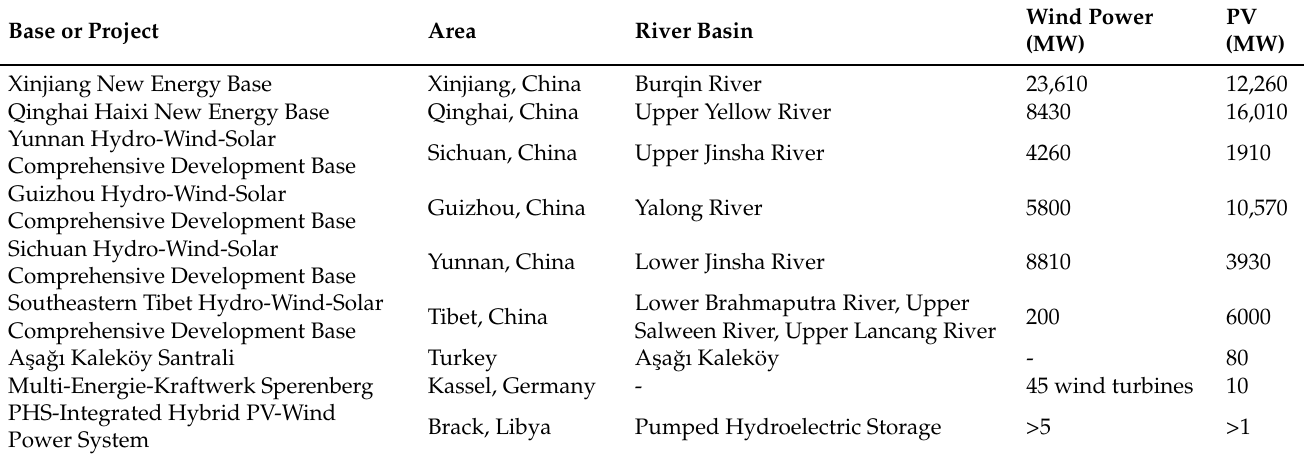
Figure 3. Highest onshore wind ( left chart ) and utility-scale PV ( right chart ) capacity potential countries and the CF tranche breakdown. Table 1. Installed capacity of hydro, wind, and solar power on an integrated basis by countries up to